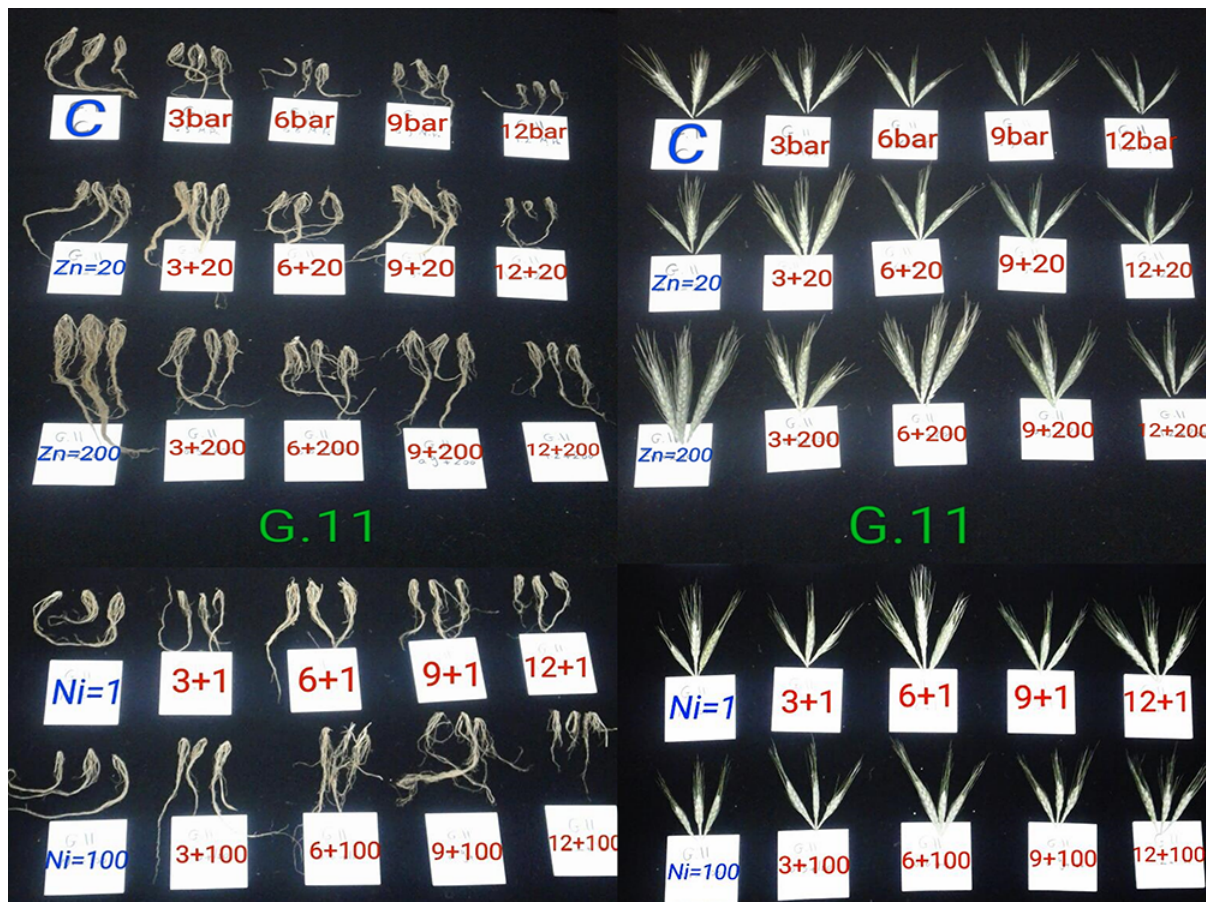
Figure 1 Roots and spikes in wheat treated by different NaCl-induced osmotic stress levels with or without Zn (20 and 200 μM) or Ni (1 and 100 μM) supplementation.